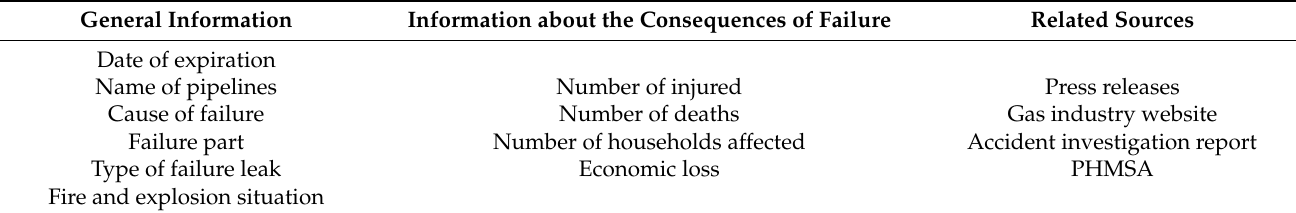
Table 1. Urban gas PE pipeline failure database